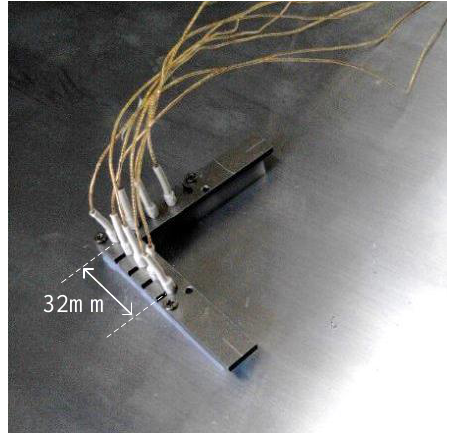
Figure 13. The 8-sensor array.